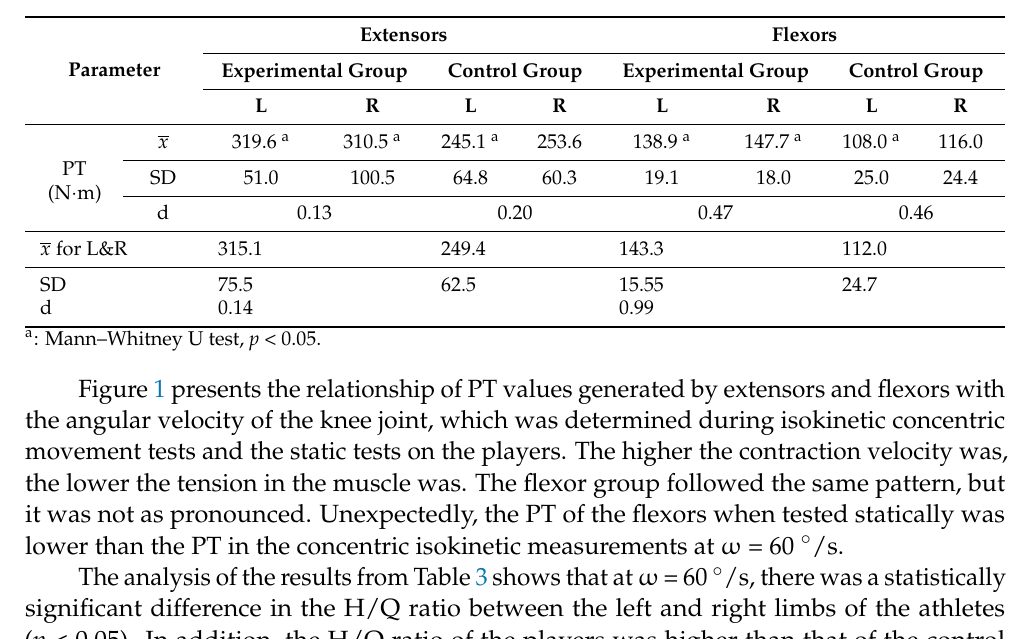
Table 2. Peak torques of the knee joint extensor and flexor obtained during a static test with a knee joint angle of α = 90 ◦ (mean ±